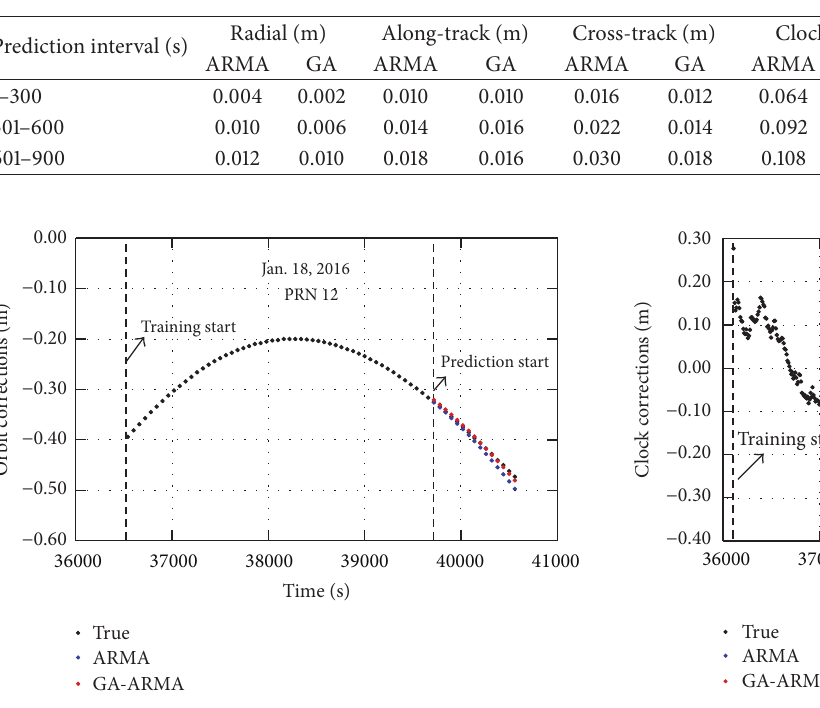
Table 1: Prediction RMS errors for three prediction intervals (all satellites, January 18, 2016).